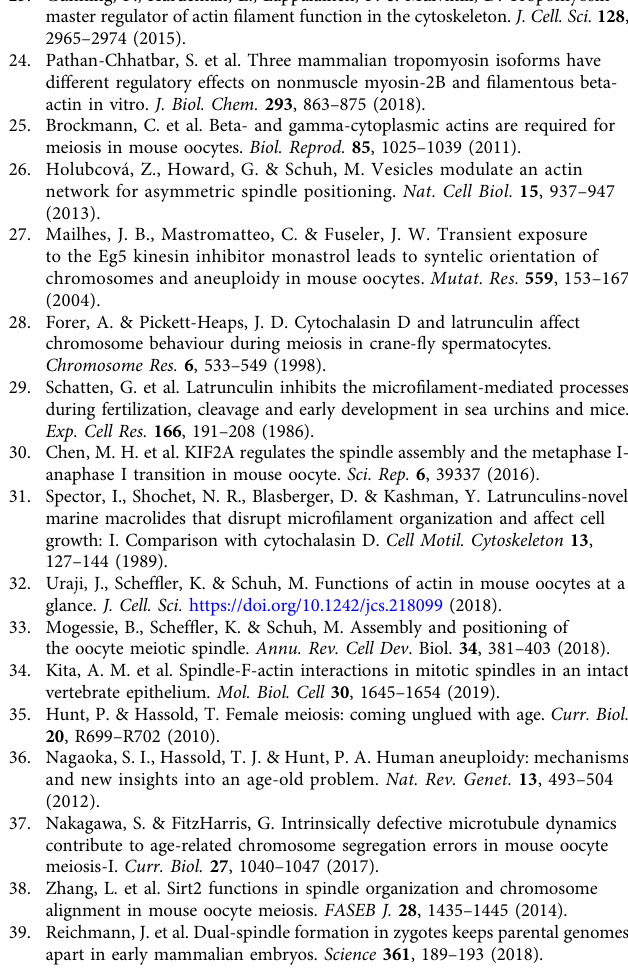
plots, center lines represent mean values, error bars show standard deviations and boxes illustrate 25th and 75th percentiles. For experiments with binary outcome, Fisher ’ s exact test was used to test for signi fi cant differences between groups. Here, error bars represent standard error of the mean. Asterisks are used to denote p - values: *<0.05, **< 0.01 and *** <0.001. n declares the number of oocytes used, the number of donors is stated within